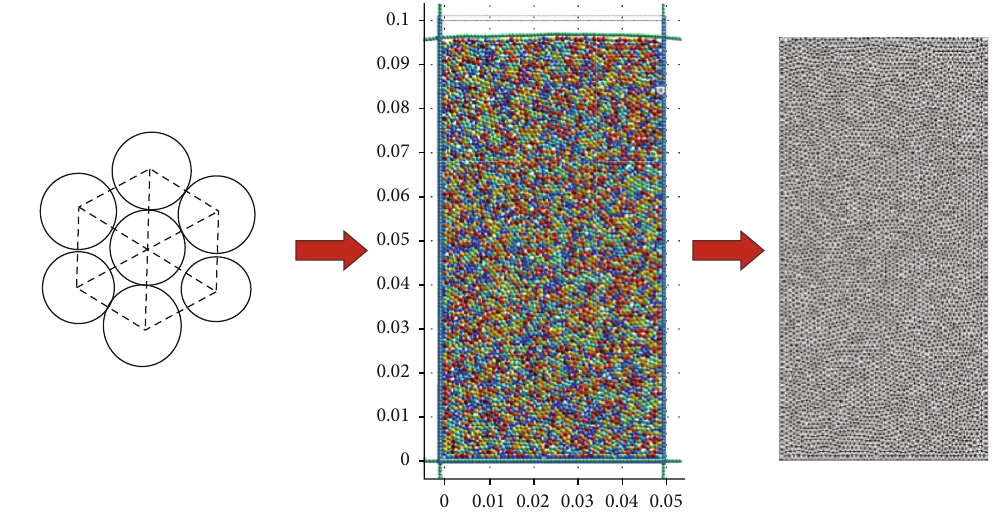
Figure 1: Numerical model of gas-containing coal sample and triangulation network. Table 1: Microscopic parameters for numerical simulation. Average normal sti ff